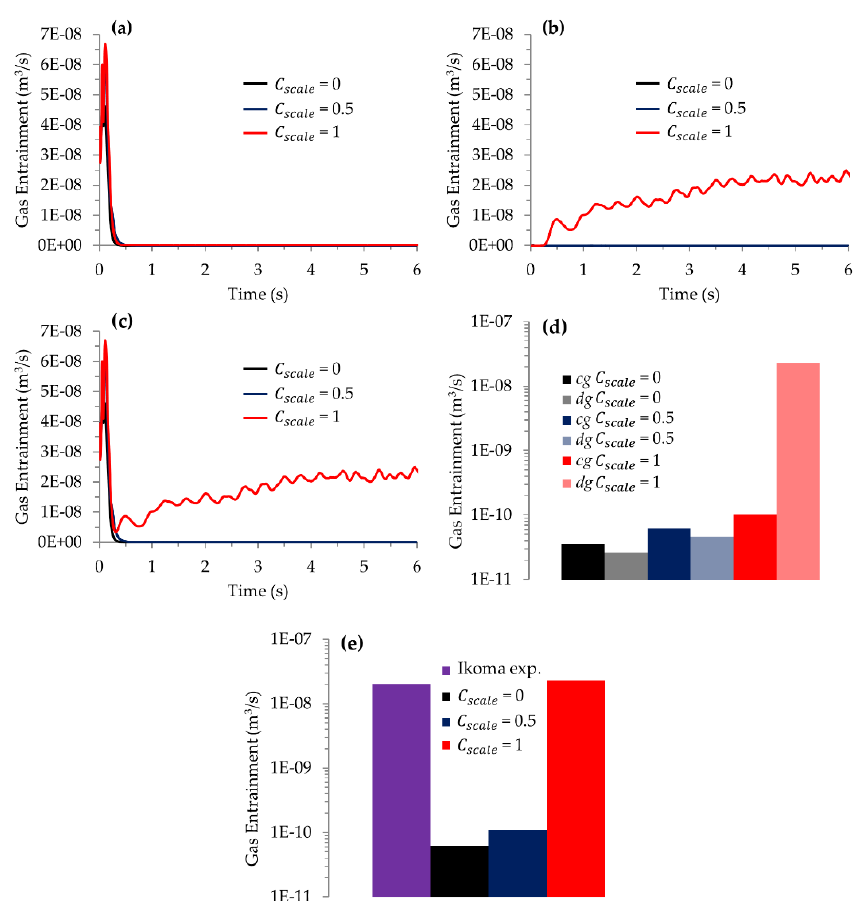
Figure 5. Transient profile of gas entrainment rate of: ( a ) potentially continuous gas cg , ( b ) dispersed gas dg , and ( c ) total gas. ( d ) Average gas entrainment rate of cg and dg and ( e ) total. The results are obtained from the simulations using C ent = 2 × 10 − 4 . The experimental gas entrainment rate is based on [71,72].